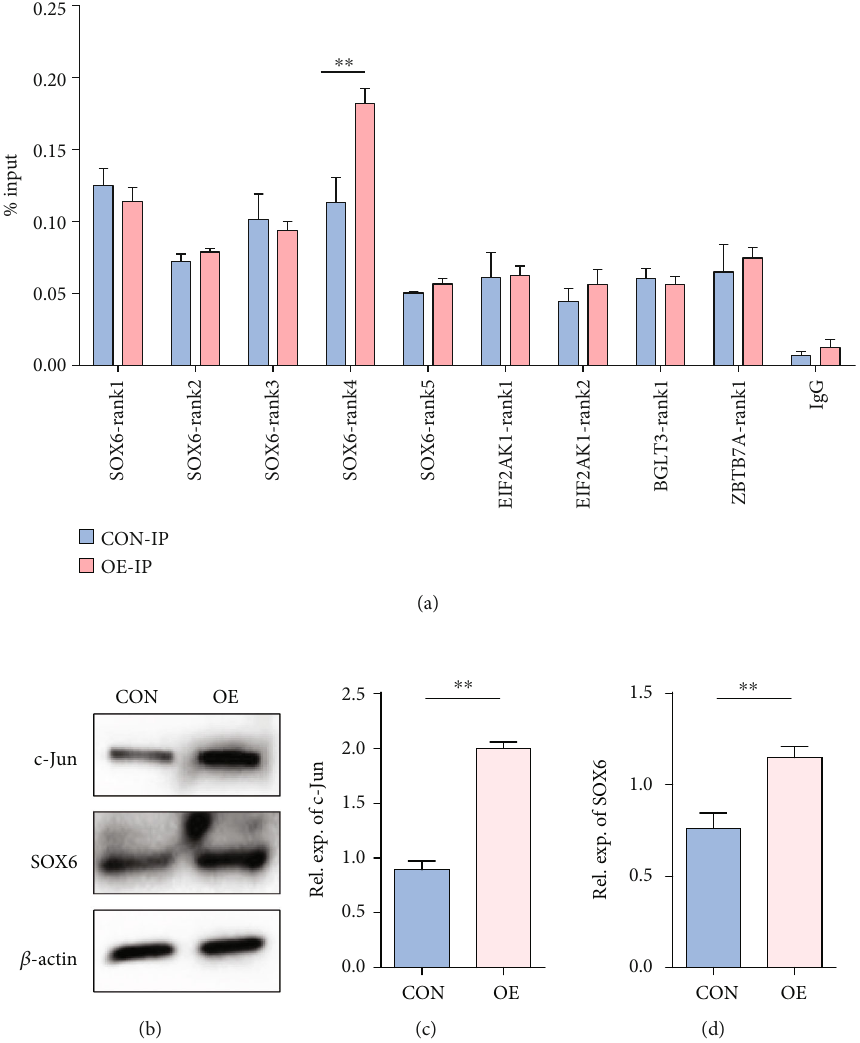
Figure 6: Overexpression of ANTXR1 promoted the combination of c-Jun and SOX6 . (a) ChIP-qPCR assays were performed using K562 cells expressing ANTXR1 , while an empty vector served as a control. The immunoprecipitated DNA of SOX6 , EIF2AK , BGLT3 , and ZBTB7A 4 binding site to c-Jun, as well as input DNA, were used as templates for quantitative fl uorescence PCR. The enrichments were quanti fi ed by ChIP-qPCR and normalized by comparison to input DNA (% input). (b) After overexpression of c-Jun in K562 cells, the protein levels of c-Jun and SOX6 were measured by western blotting. (c, d) Quanti fi cation of the western blot. The experiments n = 3 . The error bar represents the SD. ∗∗ P < 0 : 01